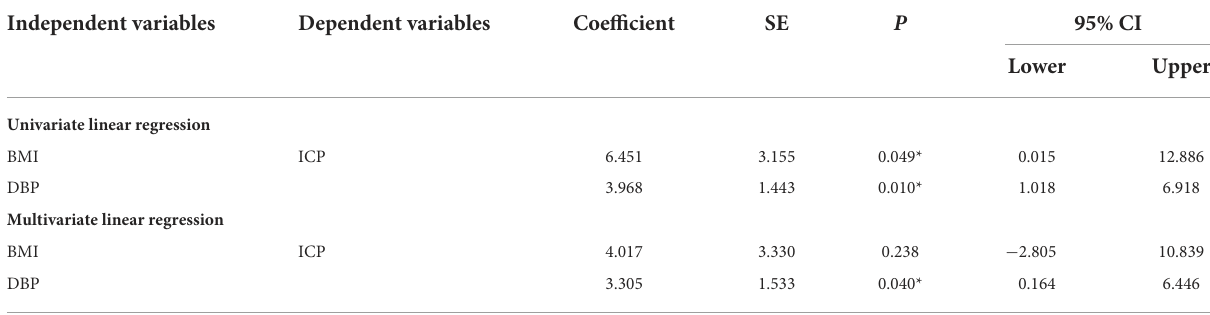
TABLE 4 Univariate linear regression analysis showed that BMI and DBP positively correlated with ICP. Independent variables